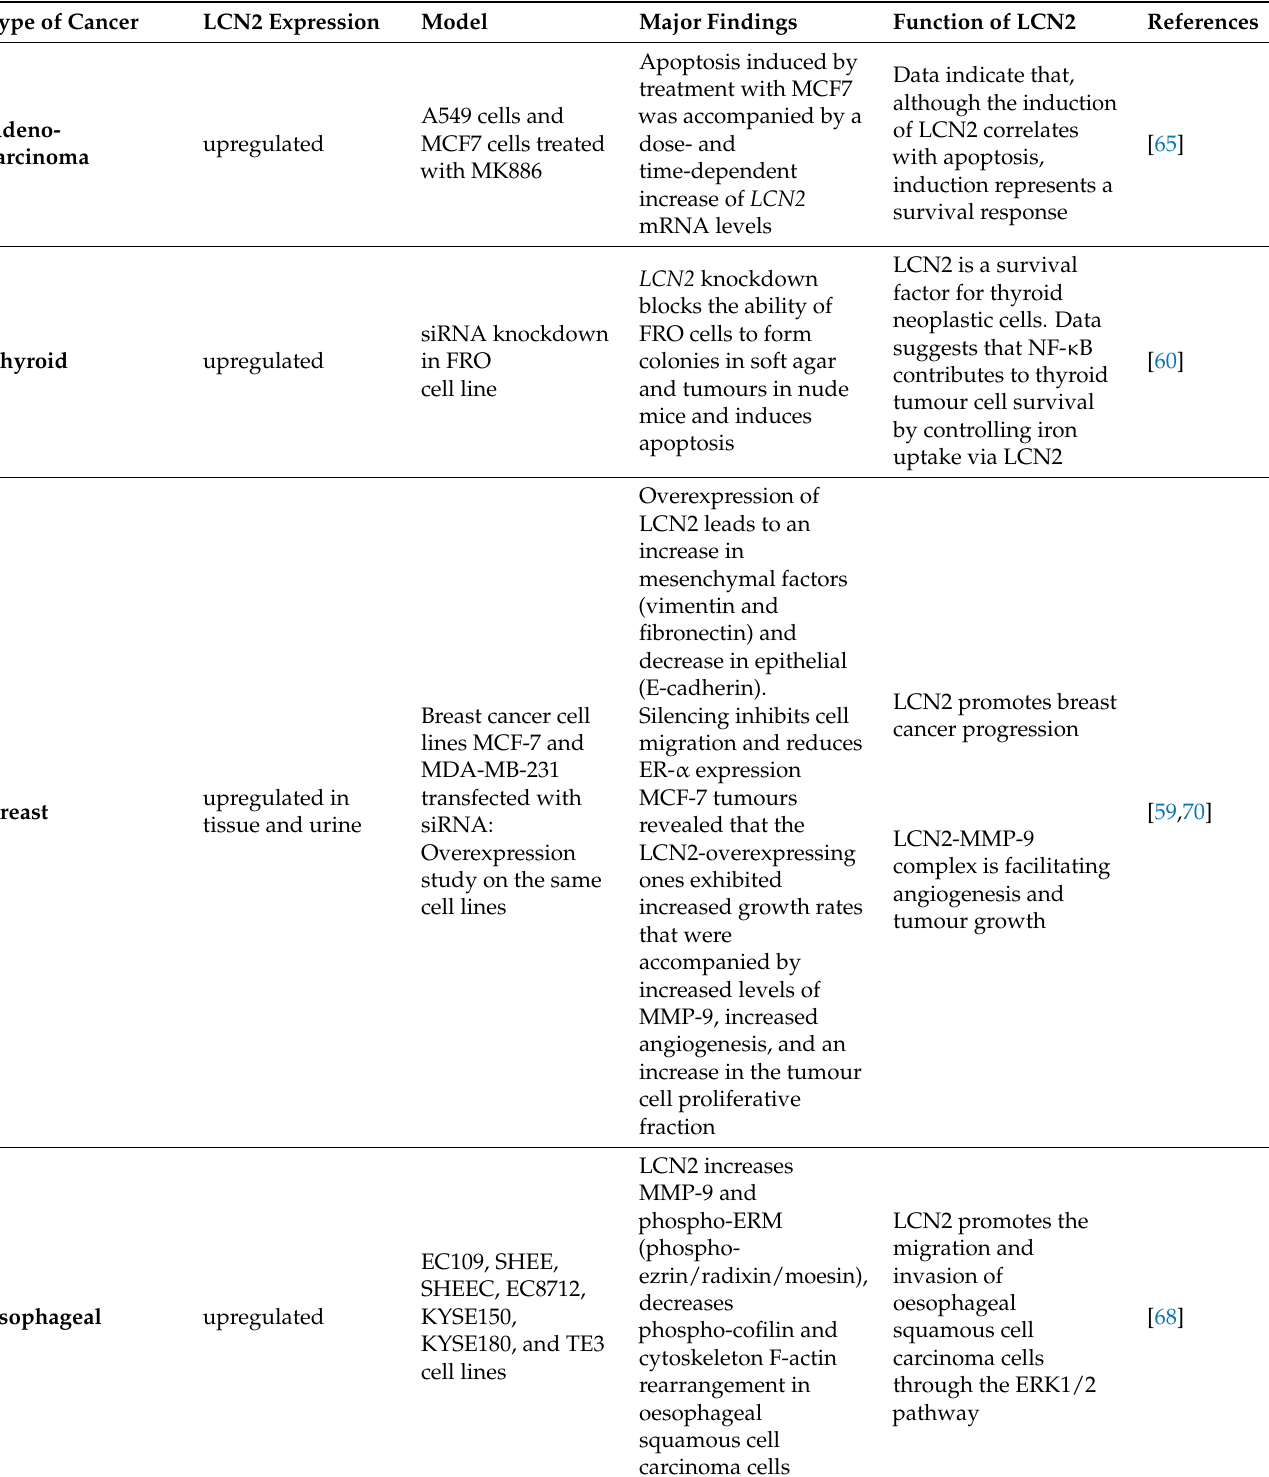
Table 1. Selected experimental and clinical findings associated with LCN2 in cancer models, tissues, and cell lines. Type of